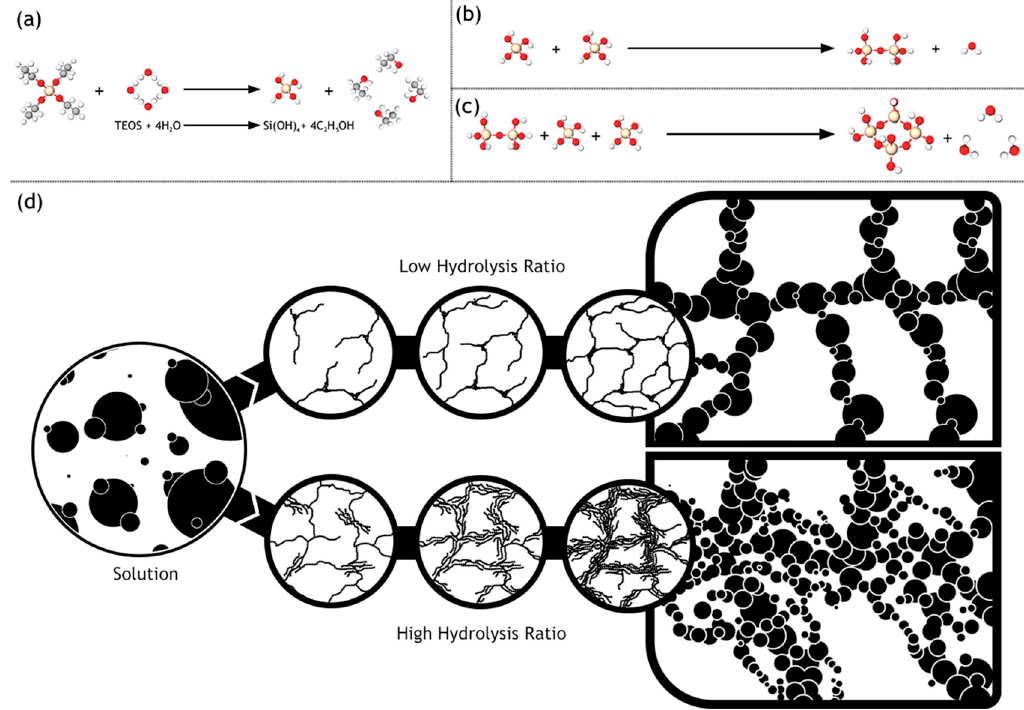
Figure 2. ( a ) Ball and stick model representation of the mixing reaction giving rise to the Si(OH) 4 tetrahedra. ( b , c ) Ball and stick model representation of the polycondensation reactions resulting in cyclic species. ( d ) The role of the hydrolysis ratio in determining the structural characteristics of the resulting porous membrane upon the commencement of gelation.